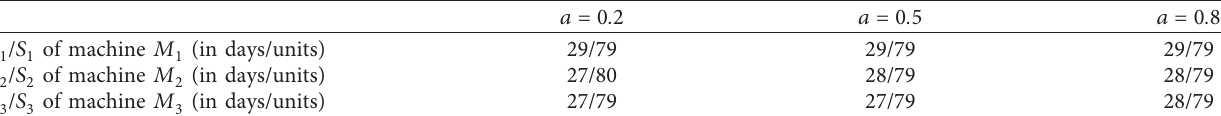
Table 8: The optimal monitoring time T and the optimal stock S of each machine in the intelligent series system with different a .